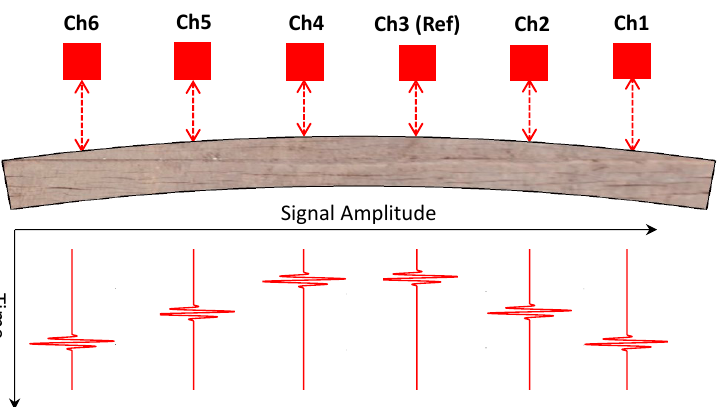
Figure 3. Schematic diagram of transducer array and corresponding waveforms for a tie with center-binding (negative